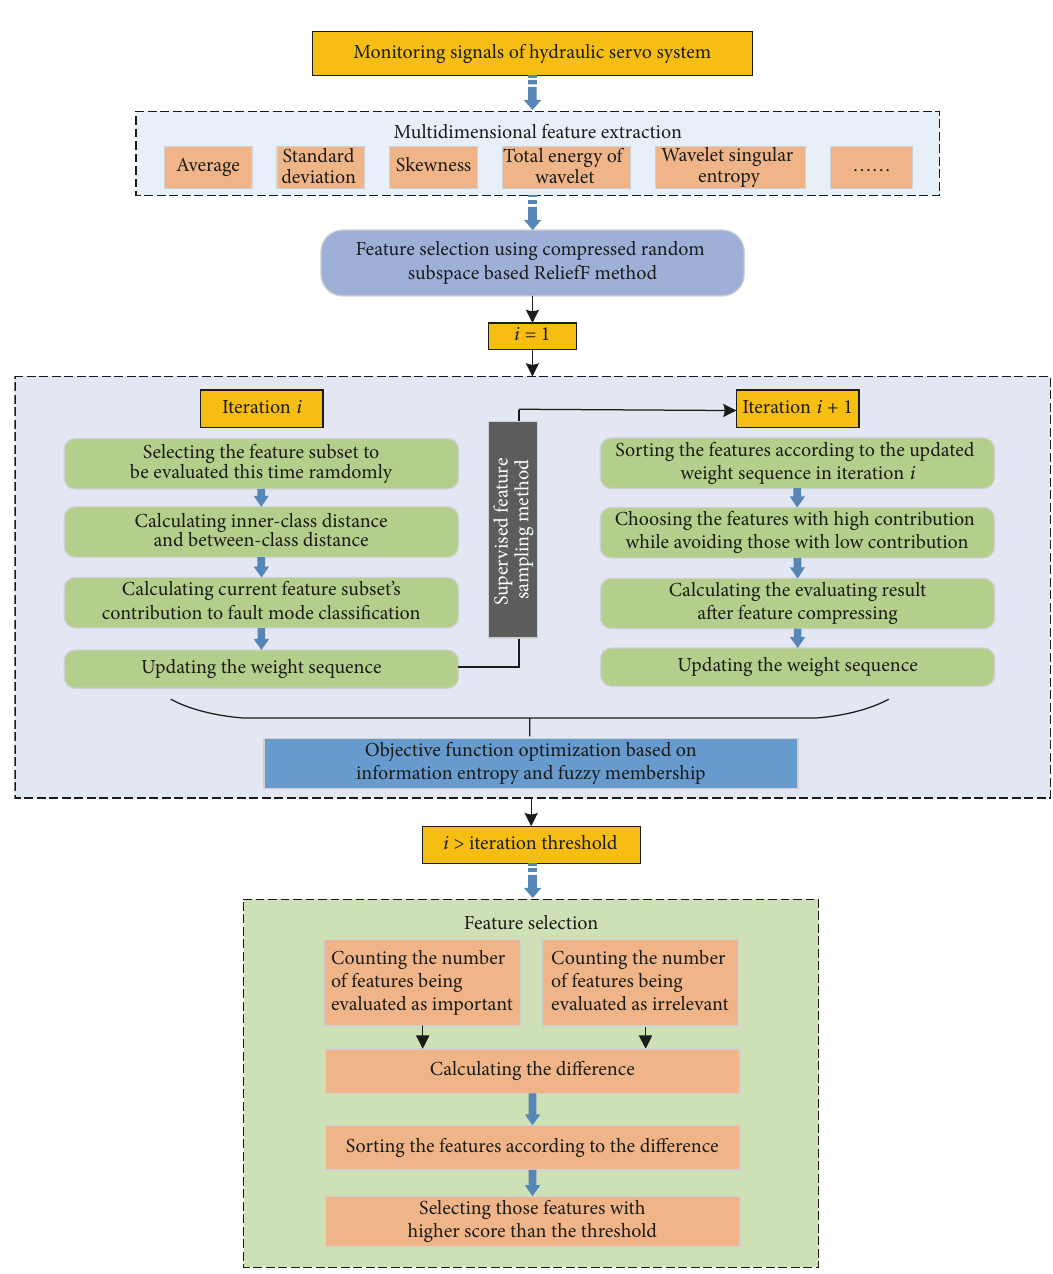
Figure 1: Process of CRSR based feature selection method for hydraulic servo pump.